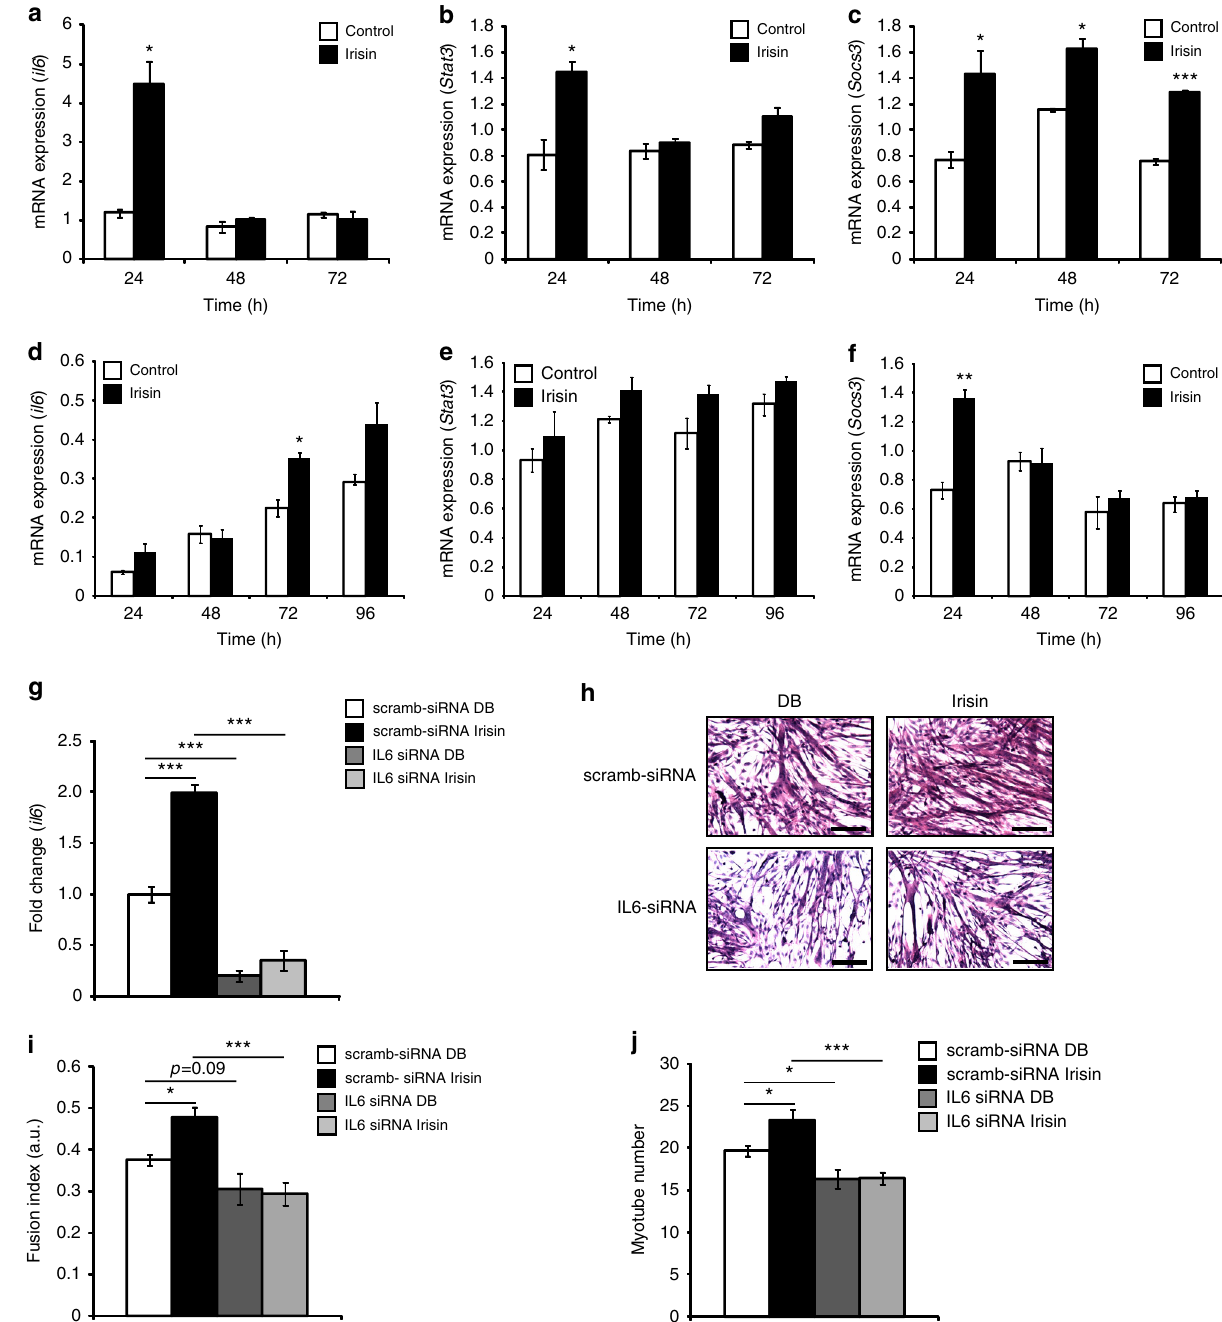
Fig. 6 Irisin treatment activates the IL6 pathway. Graphs displaying qPCR analysis of IL6 ( a ), Stat3 ( b ), and Socs3 ( c ) in proliferating myoblasts at 24, 48, and 72 h treated with DB (control) or irisin (1000 ng/ml). Graphs displaying qPCR analysis of IL6 ( d ), Stat3 ( e ), and Socs3 ( f ) in differentiating myoblasts at 24, 48, 72, and 96 h treated with DB (control) or irisin (1000 ng/ml). Graphs displaying qPCR analysis of IL6 ( g ) at 48 h treated with DB (control) or irisin (1000 ng/ml) in myoblasts transfected with IL6-speci fi c siRNA (IL6 siRNA) or scrambled siRNA-transfected myoblasts (scramb-siRNA). All qPCR graphs show gene expression normalized to gapdh . h Representative images of H&E-stained IL6 knockdown (IL6 siRNA) and IL6-positive (scramb-siRNA) myoblasts differentiated for 72 h in the presence of DB (control) or irisin (1000 ng/ml). i Graph showing quanti fi cation of fusion index of IL6-knockdown (IL6 siRNA) and IL6-positive (scramb-siRNA) myoblasts differentiated for 72 h in the presence of DB (control) or irisin (1000 ng/ml). j Graph showing quanti fi cation of myotube number of IL6-knockdown (IL6 siRNA) and IL6-positive (scramb-siRNA) myoblasts differentiated for 72 h in the presence of DB (control) or irisin (1000 ng/ml) ( n = 3 biological replicates for all experiments in this fi gure). Error bars represent mean ± SEM. Student ’ s t -test was performed for all fi gure panels between a and f , and two-way ANOVA was performed for all relevant fi gure panels between g and j . Signi fi cance is indicated with * p < 0.05, ** p < 0.01 and *** p <